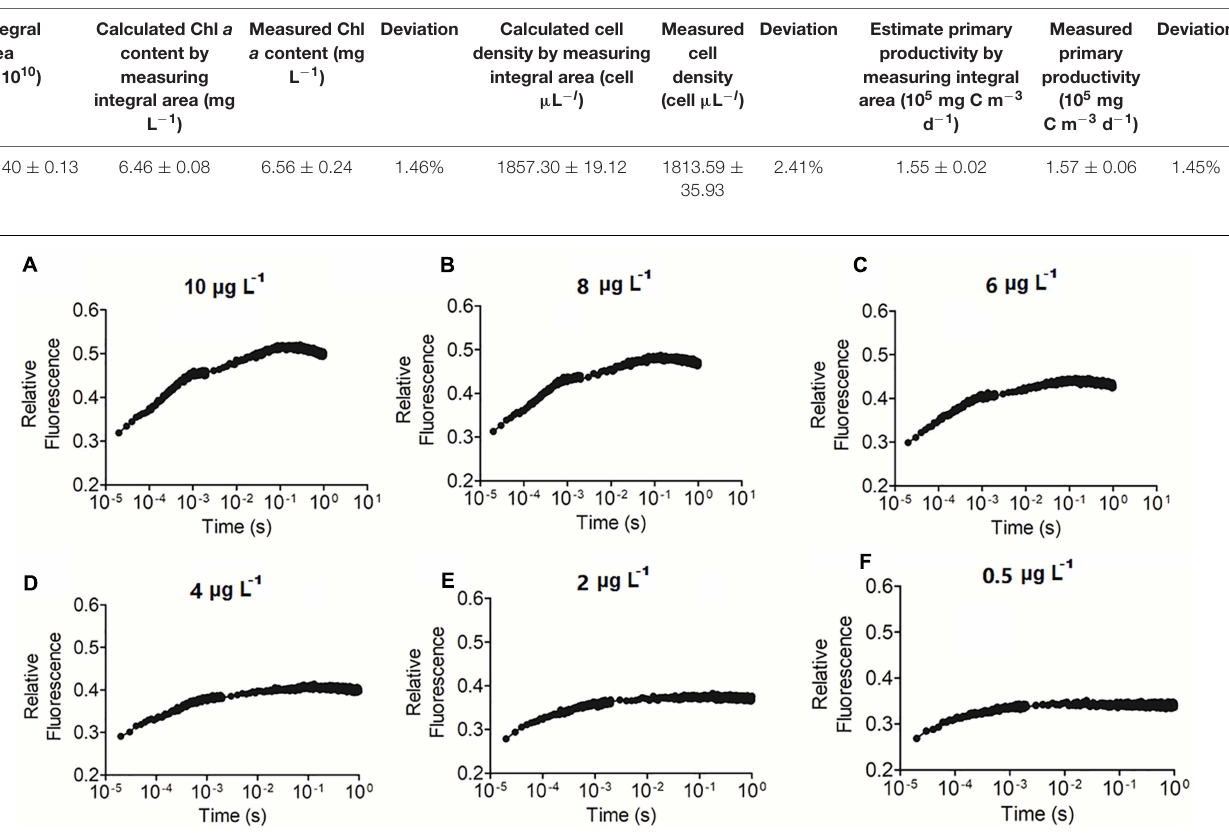
FIGURE 3 | Linear fits for the integral area of OJIP curve and cell density (A) , Chl a content (B) or primary productivity (C) for samples of pond water in Wuhan City. TABLE 4 | The validation of using the integral area of the OJIP curve for determining the Chl a content, cell density, and primary productivity in the pond of Wuhan City.